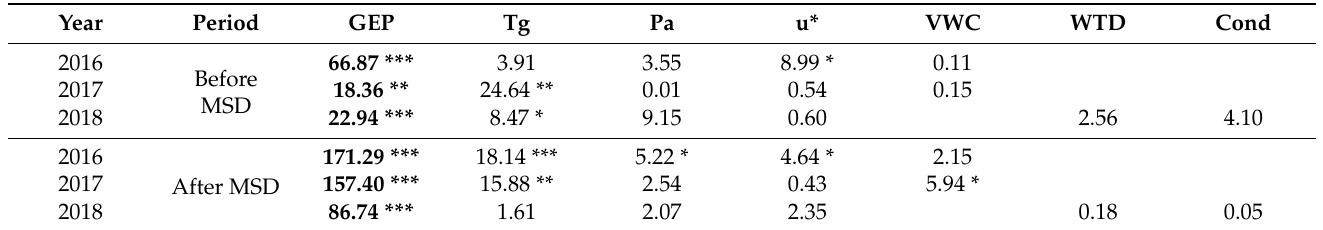
Table 2. The results of Partial F test for daily CH 4 fluxes and other variables before and after the mid-season drainage.